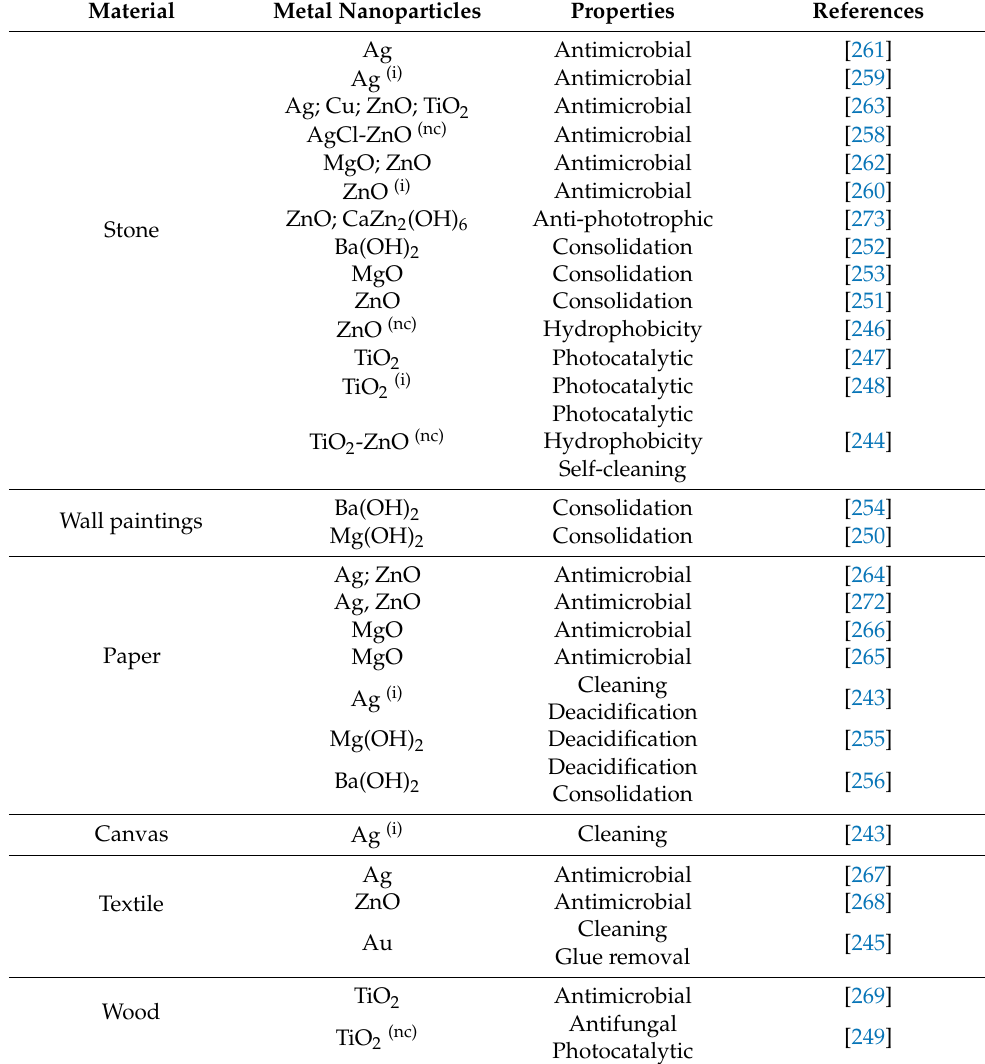
Table 4. Metal nanoparticles applied to cultural heritage materials